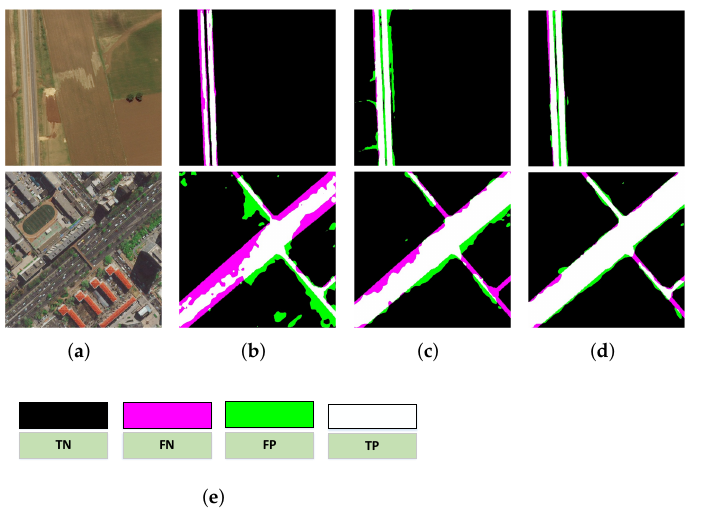
Figure 7. Some qualitative results on Dataset 3. ( a ) The original satellite images; ( b ) the results of D-linknet; ( c ) the results of MD-ResUnet; ( d ) the results of our method; ( e )